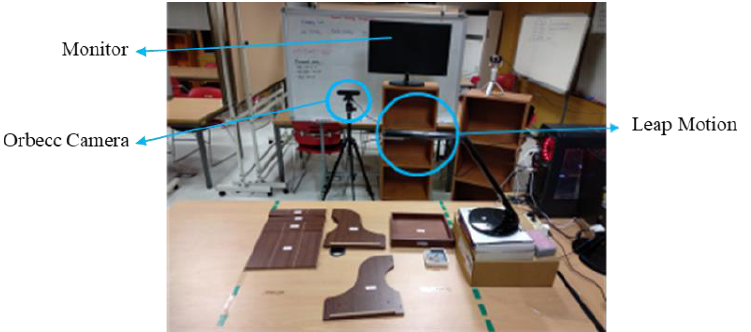
Figure 11. Laboratory Setup.